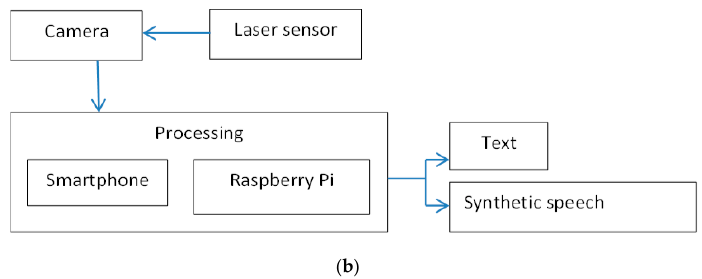
Figure 1. ( a ) System hardware and graphic user interface. The micro camera connected to the Raspberry Pi hardware is embedded in the glasses; ( b ) Schema of the hardware prototype.